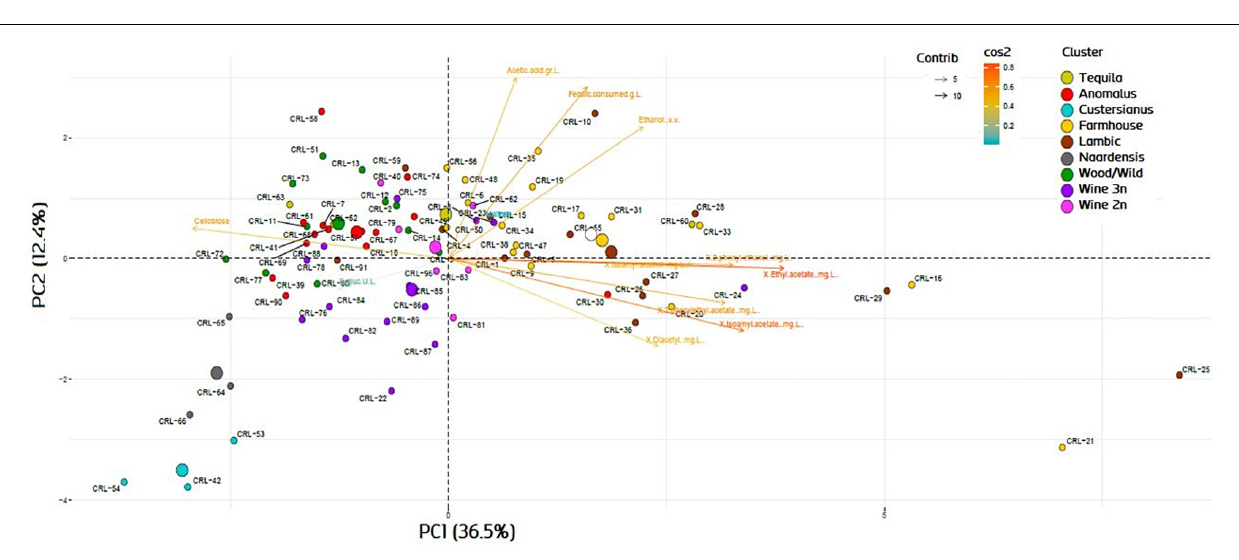
FIGURE 10 | Bi-plot with principal component analysis variable loadings of Brettanomyces strains included in the study. Variable loadings are measured by cos2